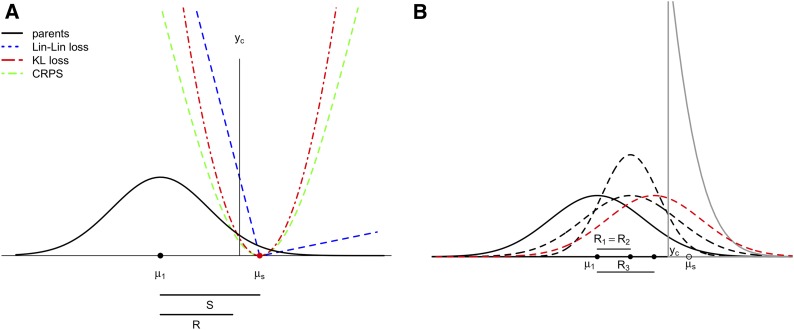
A) Classic idea of selection by truncation at yc. Loss functions need to be minimized at μs in order to favor lines with high response to selection. Losses were standardized by subtracting the minimum value for representation. Loss functions Kullback-Leibler (KL) and Continuous Ranked Probability Score (CRPS) are symmetric on both sides of target μs, while LinLin loss is asymmetric. B) The solid line in black represents the base population, the solid gray line corresponds to the truncated distribution after censoring at yc representing the breeder’s preferences. Dashed lines are theoretical distributions of three possible candidates. The candidates’ distribution with mean close to the theoretical μs (the greater R red dashed line) and variance similar to that of the parent distribution has the minimum loss.